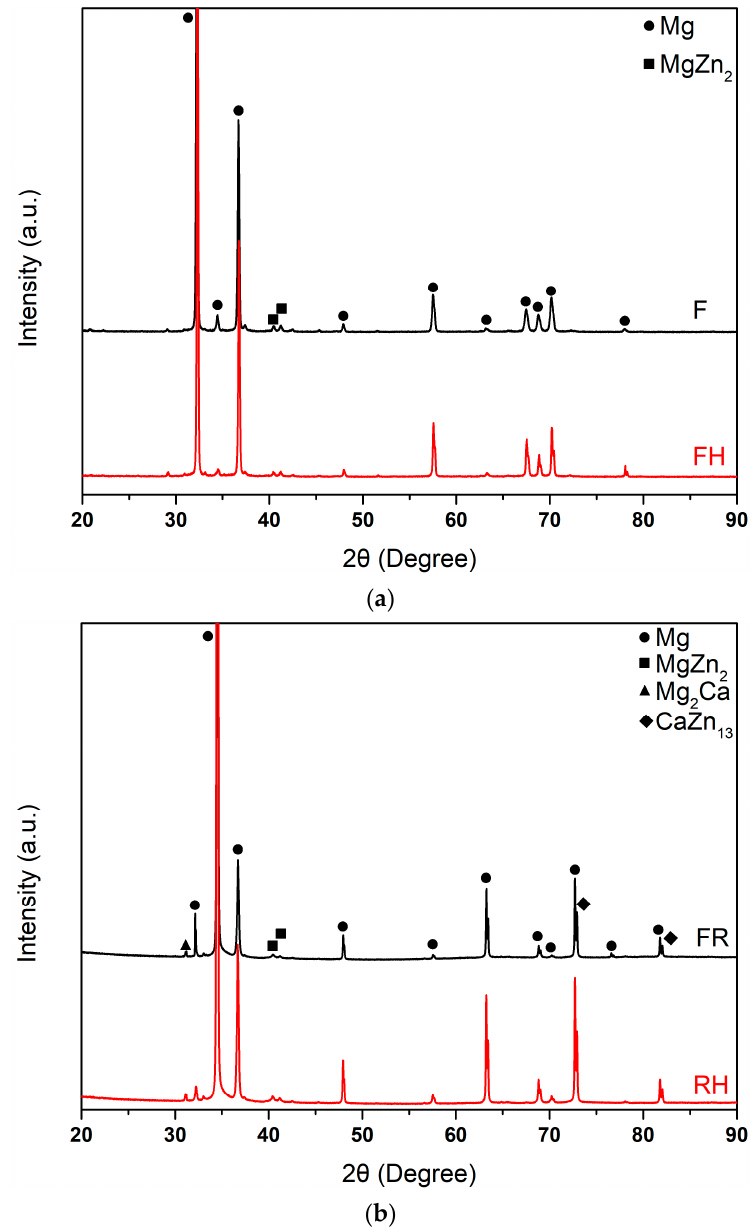
Figure 5. XRD patterns of ZKX500: ( a ) F and FH, and ( b ) FR and RH.